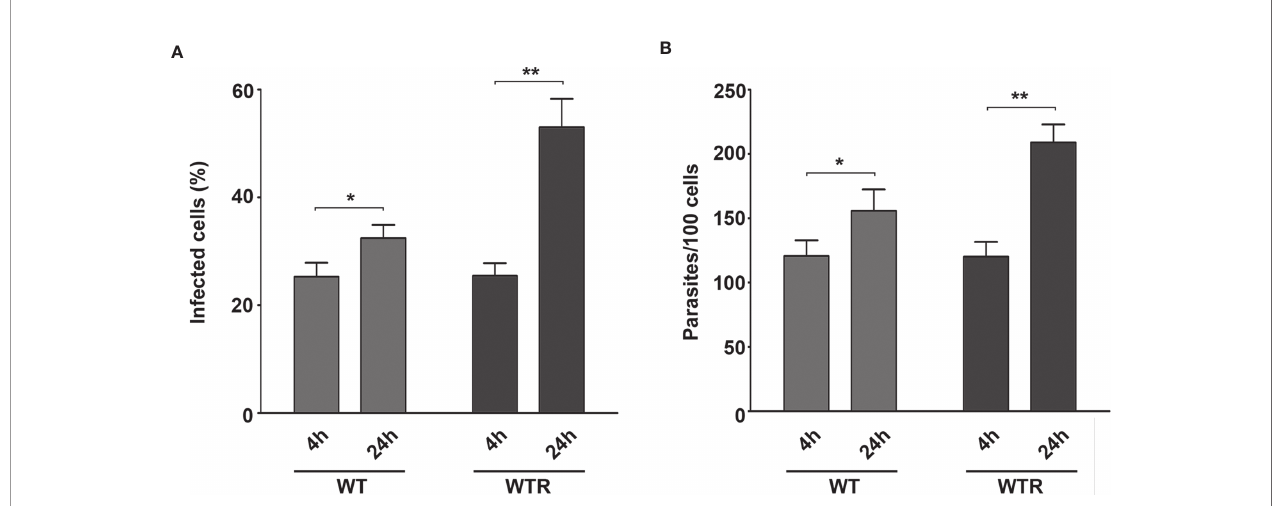
FIGURE 5 | Strigomonas culicis hydrogen peroxide (H 2 O 2 )-resistant (WTR) had higher infection rates in Aag2 cell culture at 24 (h) Epithelial cells were infected with wild type (WT) and WTR strains for 4 (h) After that, non-adhered parasites were discarded, and Aag2 cell culture was maintained until 24 (h) (A) The percentage of infected cells (*p = 0.01, **p = 0.004) and (B) the number of adhered parasites per 100 cells (*p = 0.01, **p = 0.003) were calculated at both time points. Signi fi cant p-values were obtained by Mann – Whitney test, and error bars represent the mean ± SD of at least four independent